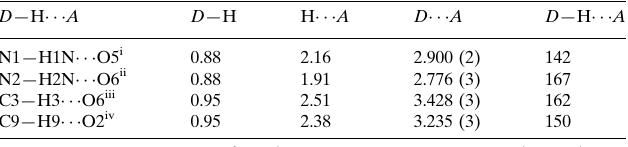
Hydrogen-bond geometry (A˚ , (cid:2)